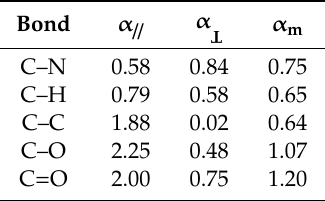
Figure 9. Simple schematic of orientation polarization, interface polarization and dipole polarization happened in PI films. Table 3. Polarizabilities of the chemical bonds parallel and normal to the bond axis and the mean value for all three directions in space [24].